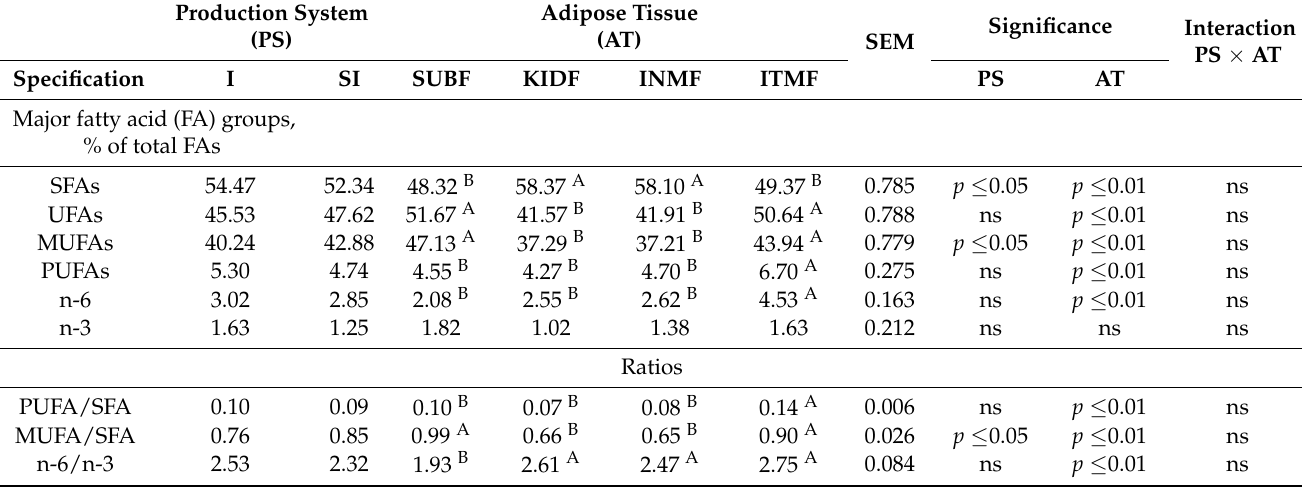
Table 4. Effect of production system and type of adipose tissue on the fatty acid profile, fatty acid groups and ratios. Production